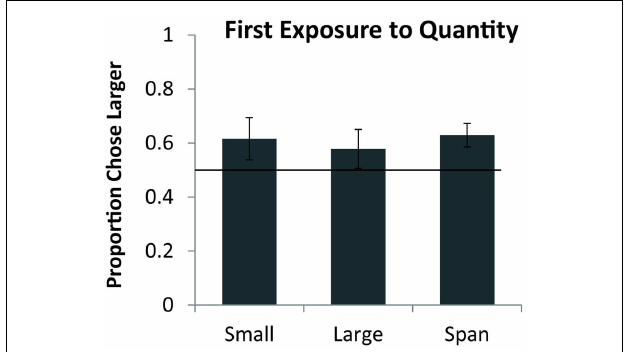
FIGURE 3 |Average accuracy for eight monkeys on the small (both numbers < 5), large (both numbers > 4), and span pairs (one number < 5 and one number > 4) on their first exposure to numerical discrimination . Chance is a 0.5 probability. Error bars represent the standard error of the mean across